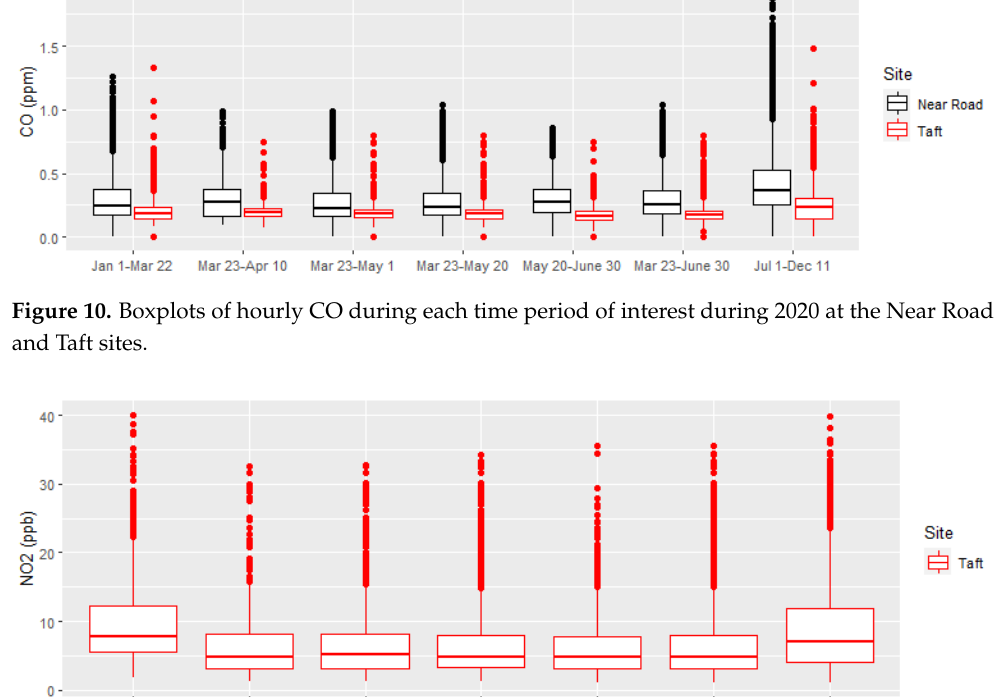
Figure 11. Boxplots of hourly NO 2 during each time period of interest during 2020 at the Taft site.